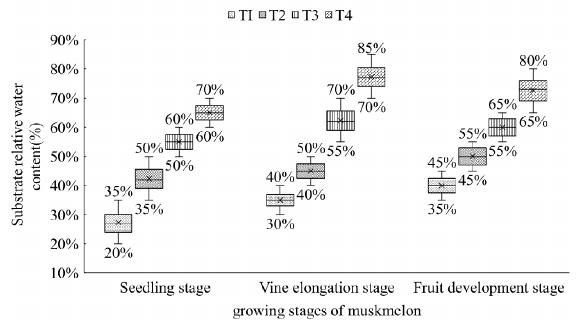
Figure 1. Substrate relative water content (%) in four treatments at three growing stages of muskmelon. T1: 20%~35% relative water content (RWC) at seedling stage, 30%~40% RWC at vine elongation stage, and 35%~45% RWC at fruit development stage. T2: 35%~50% RWC at seedling stage, 40%~50% RWC at vine elongation stage, and 45%~55% RWC at fruit development stage. T3: 50%~60% RWC at seedling stage, 55%~70% RWC at vine elongation stage, and 55%~65% RWC at fruit development stage. T4: 60%~70% RWC at seedling stage, 70%~85% RWC at vine elongation stage,